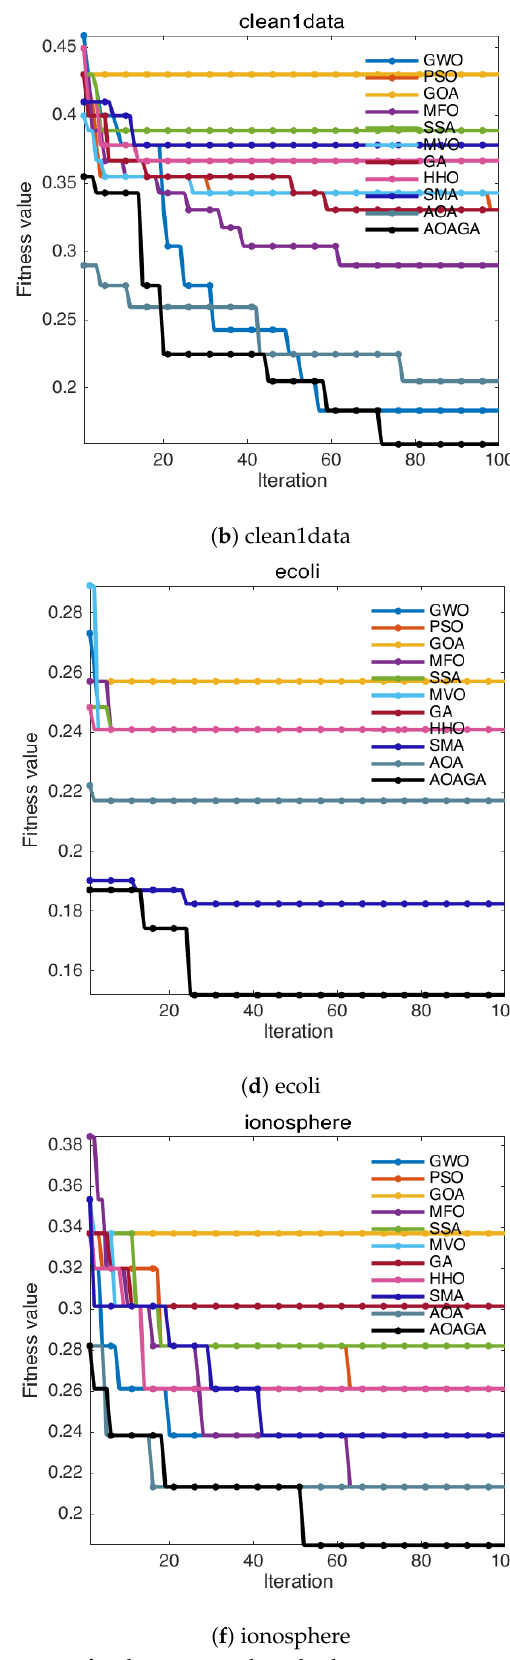
Figure 5. Examples of the convergence curves for the compared